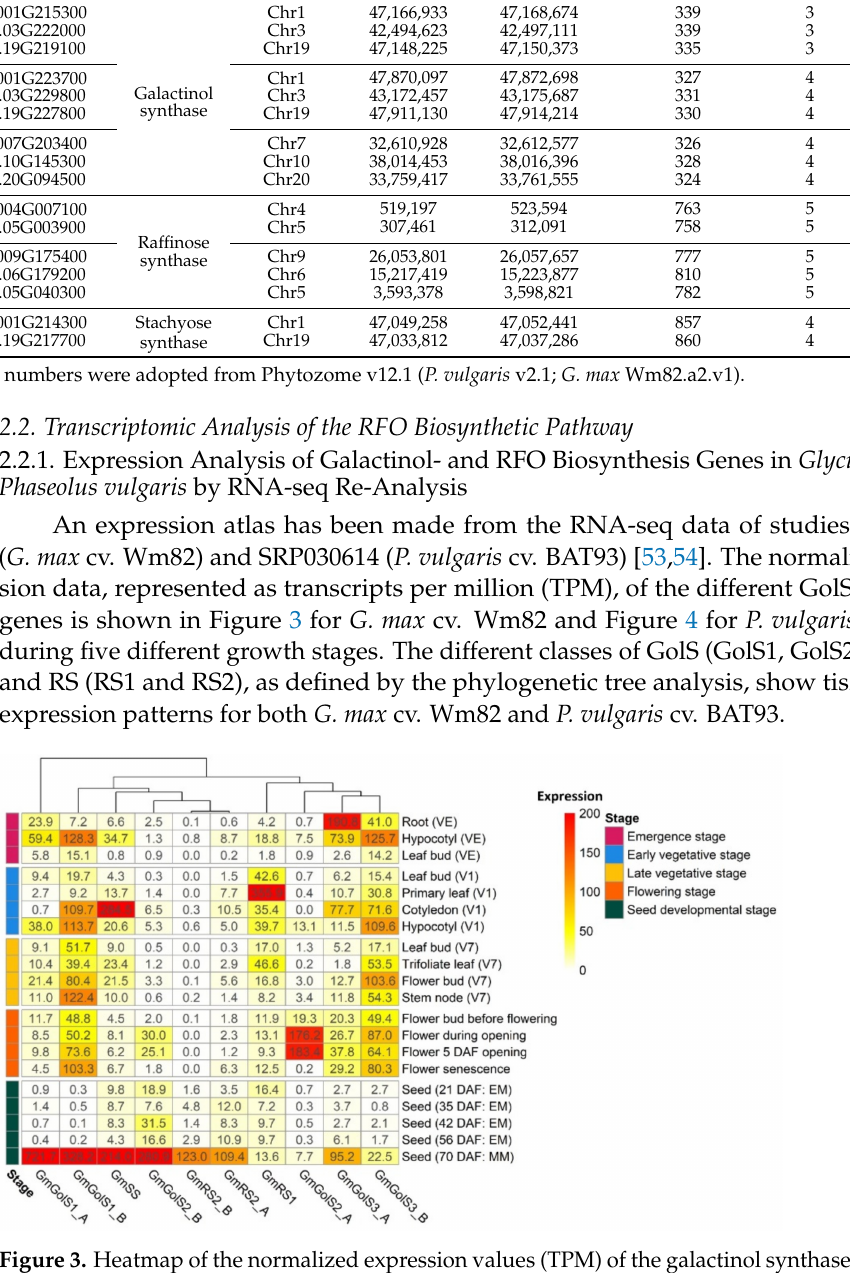
Table 1. Overview of the enzymes involved in the RFO biosynthesis pathway and corresponding genes. Species